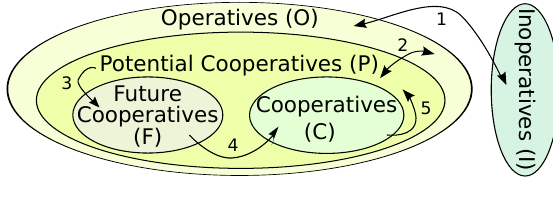
Figure 3. Roles of nodes in